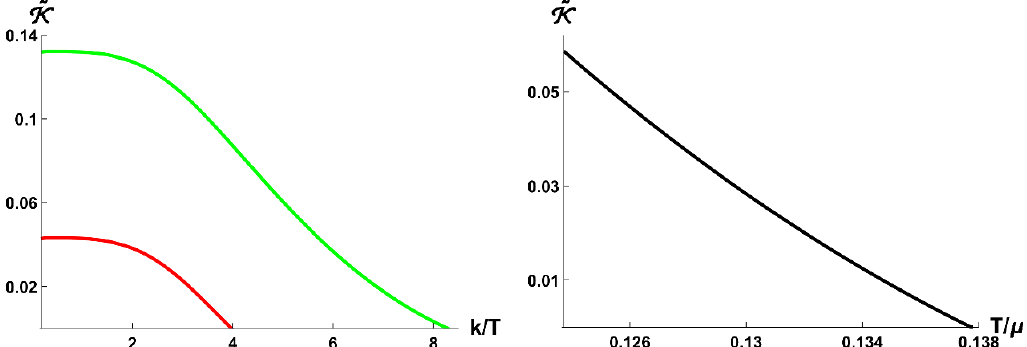
Figure 8 . The reduced bulk elastic modulus ~ K = 16 (cid:25)G N K =k 4 (left panel) as a functions of k=T (cid:8) 1 (cid:9) for select values of T = ; 1 , f red ; green g curves, at the criticality. The right panel presents the (cid:22) 12 6 same quantity as a function of T=(cid:22) close to criticality at (cid:12)xed value k